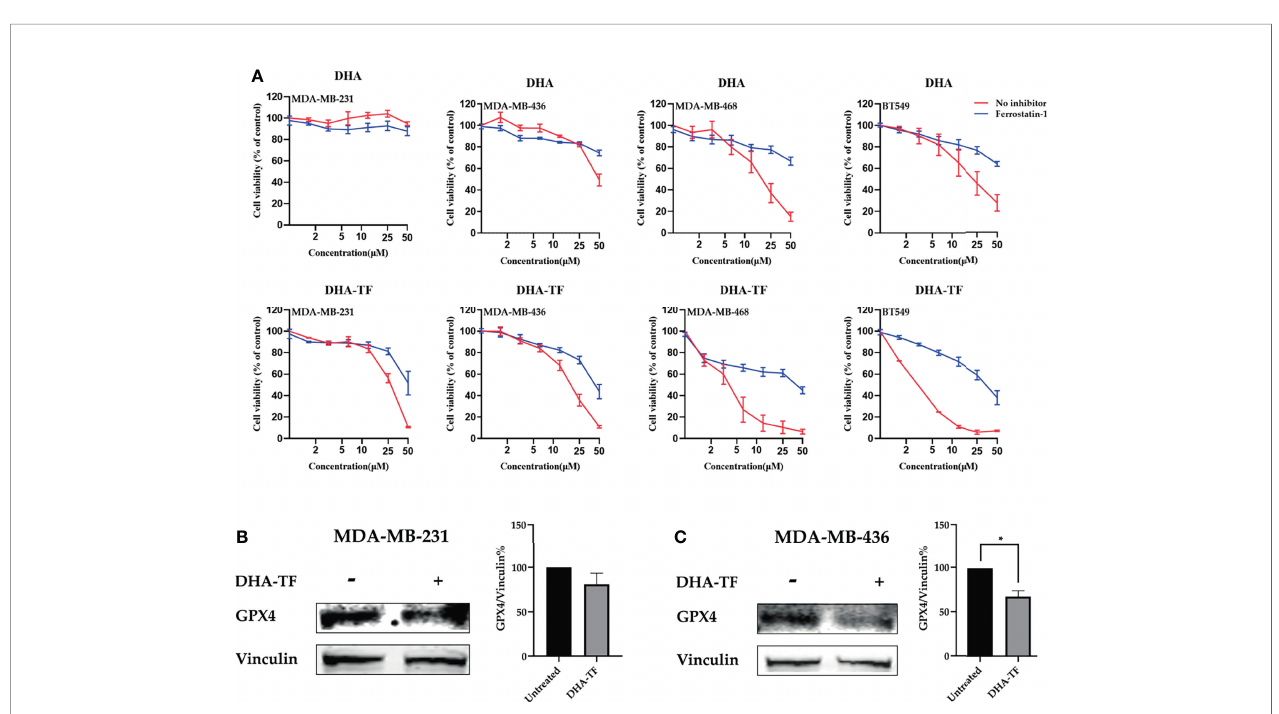
FIGURE 4 | DHA-TF adducts induce ferroptosis in TNBC cell lines. (A) Cells were treated with ferrostatin-1, followed with increasing concentration of DHA or DHA- TF in each cell line for 24 h. Data shown are mean ± SEM from three independent experiments performed in triplicate. The GPX4 expression was analyzed in (B) MDA-MB-231 and (C) MDA-MB-436 after treatment with/without 15 m M DHA-TF. The relative GPX4 expression was calculated based on integrated density and shown in bar chart. The Date shown are mean ± SEM from duplicate independent experiments. *0.01 < p ≤